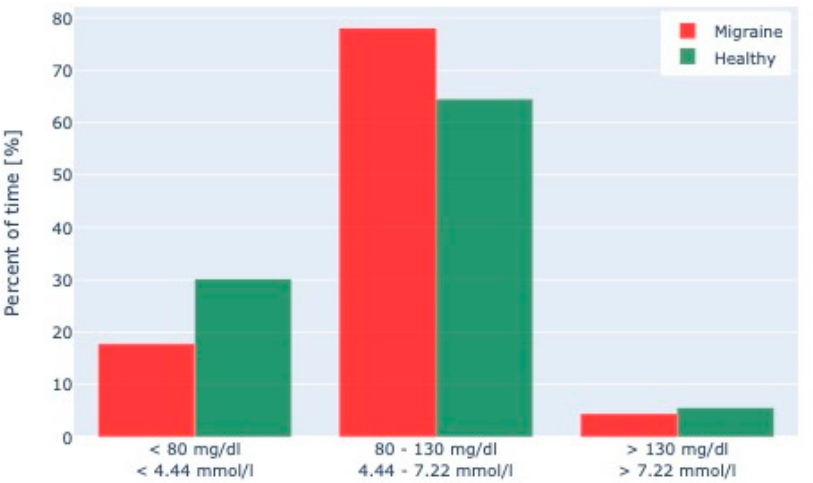
Figure 2. Continuous Glucose Monitoring (CGM) data of migraine patients and healthy patients. A comparison of CGM data of 49 migraine patients with those of 103 healthy individuals matched for BMI, age, and weight showed that migraine patients spent significantly more time in a glucose range between 80–130 mg/dl and less in the range < 80 mg/dL.